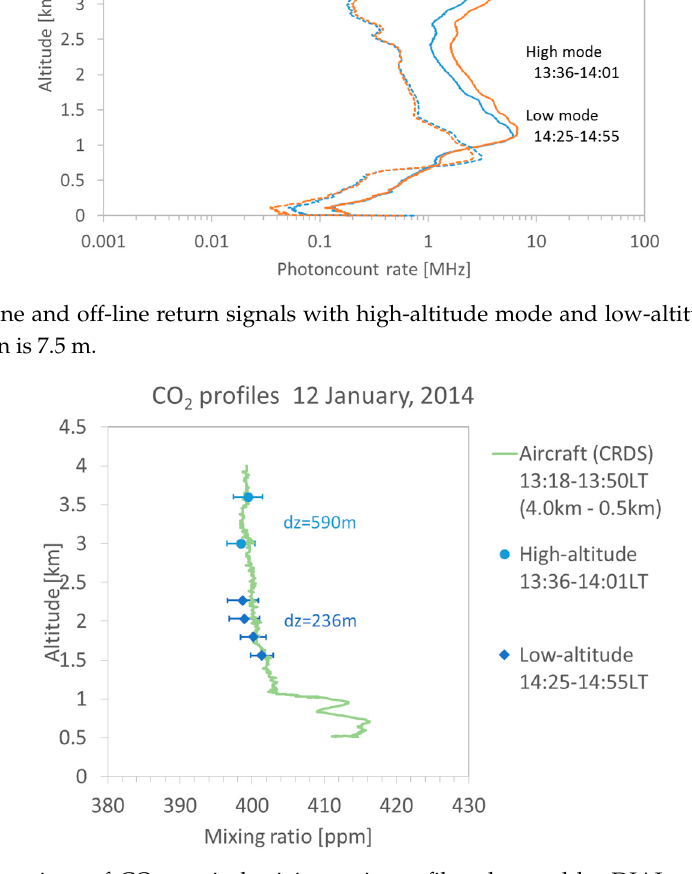
Figure 6. Comparison of CO 2 vertical mixing ratio profiles observed by DIAL and aircraft. dz: vertical resolution.